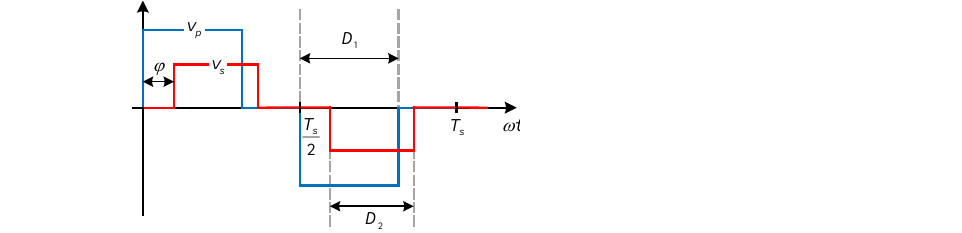
Figure 3. Primary ( v p ) and secondary ( v s ) transformer voltages for a specific modulation